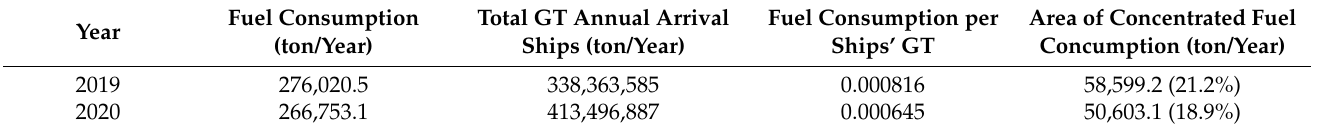
Table 6. Fuel consumption of ships underway using the engine in BP in 2019 and